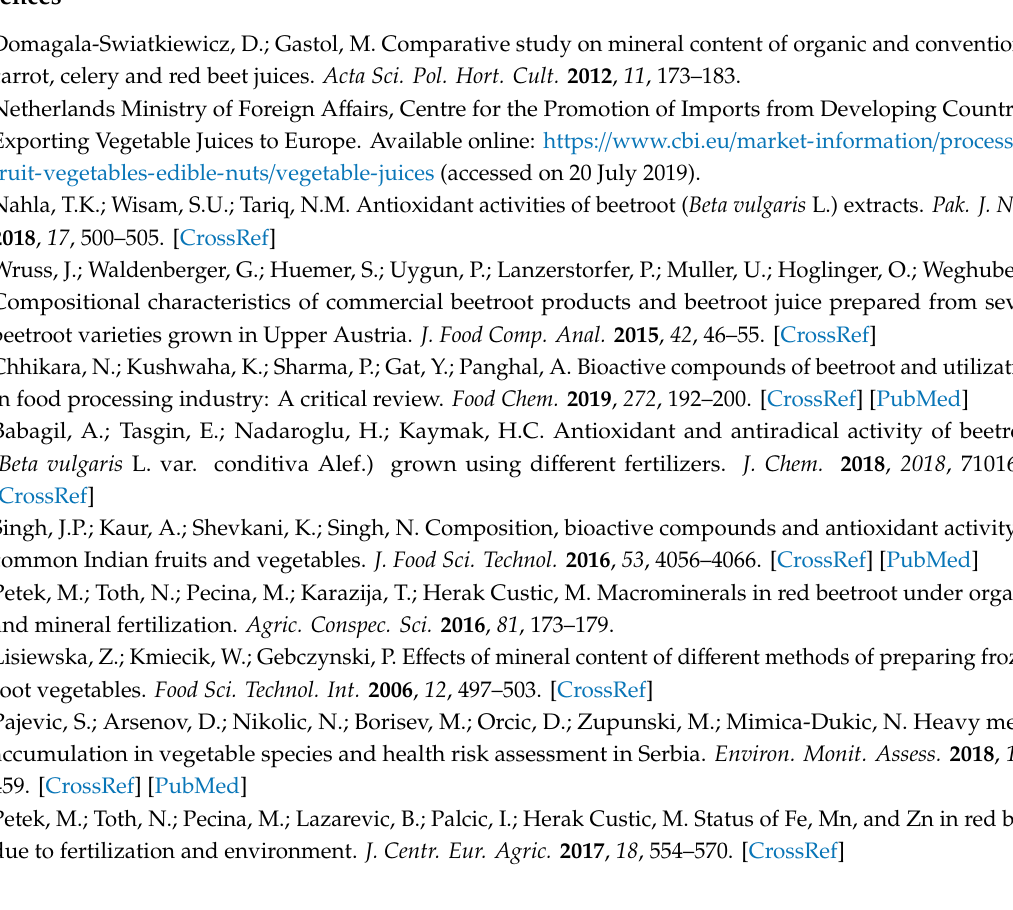
solid phase extraction (SPE) with the LC-18 and LC-SCX